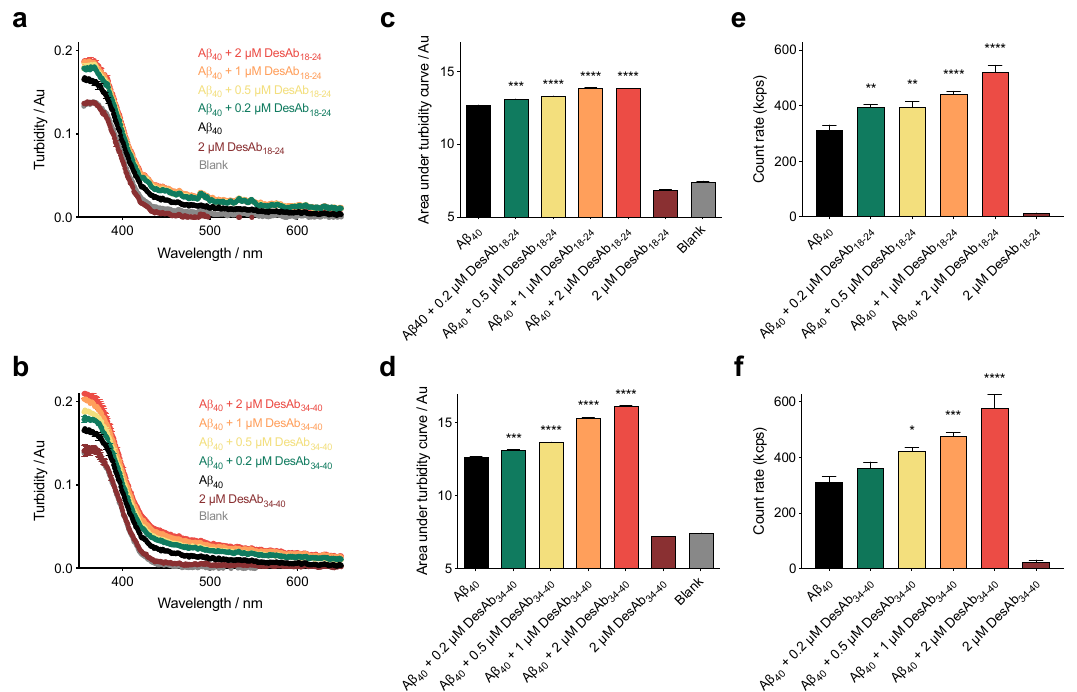
Figure 3. DesAb 18-24 and DesAb 34-40 increase the size of stabilized A β 40 oligomers. ( a , b ) Turbidity measurements for oligomers of A β 40 incubated at a concentration of 10 µ M in the absence (black) or presence of 0.2 µ M (green), 0.5 µ M (yellow), 1 µ M (orange) and 2 µ M (red) of DesAb 18-24 ( a ) and DesAb 34-40 ( b ). Samples are identical to those shown in Figure 2. ( c , d ). Turbidity traces analyzed by area under the curve integration. Note that the highest concentration of DesAbs tested (2 µ M, dark red) did not significantly change the absorbance relative to the blank (ANS, grey). Error bars denote SEM of duplicate spectra. ( e , f ) SLS measurements in the absence of ANS and the presence of A β 40 oligomers and increasing concentrations of the designed antibodies. Note negligible scattering from the highest ratio of the DesAbs tested in the absence of oligomers. Error bars denote SEM of six measurements. In all panels, the symbols *, **, *** and **** indicate p < 0.05, 0.01, 0.001 and 0.0001, respectively. Samples containing oligomers were analyzed by one-way ANOVA followed by Bonferroni’s multiple comparison test relative to oligomers in bu ff